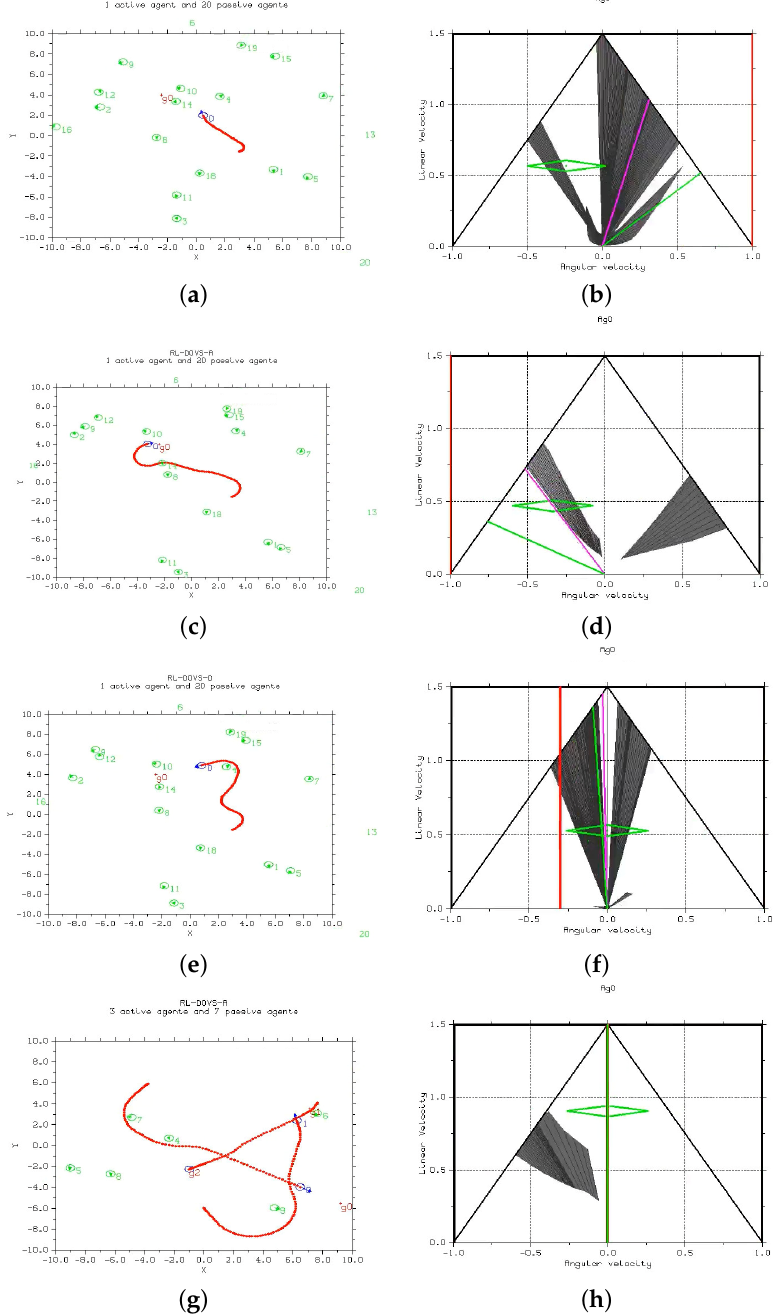
Figure 8. Workspace ( left ) and velocity space ( right ) for the three techniques and a given time step. In the workspace, the moving obstacles are in green, the robot trajectory in red. The dark areas correspond to the unsafe robot velocities that lead to collision with the surrounding obstacles. The dynamic window at the currect instant is depicted in green. ( a ) S-DOVS, 1 active-20 moving passive agents; ( b ) velocity space for S-DOVS; ( c ) RL-DOVS-A, 1 active and 20 moving passive agents; ( d ) velocity space for RL-DOVS-A; ( e ) RL-DOVS-D, 1 active and 20 moving passive agents; ( f ) velocity space for RL-DOVS-D; ( g ) RL-DOVS-A, 3 active and 7 moving passive agents; ( h ) velocity space for agent